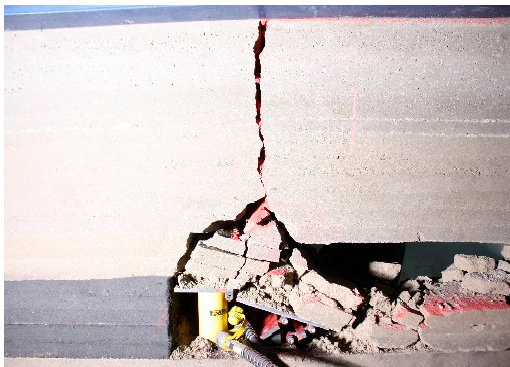
Figure 1. The main roof is cut off and the immediate roof is crushed [40].